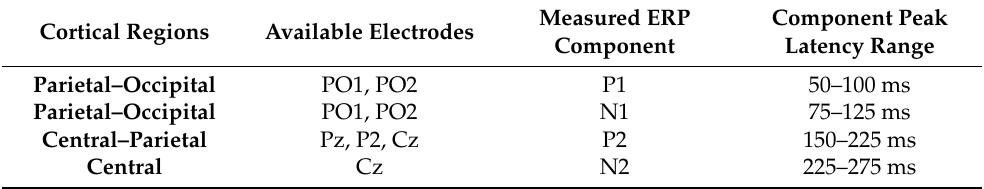
Table 2. Selection of cortical regions that used to measure the ERP